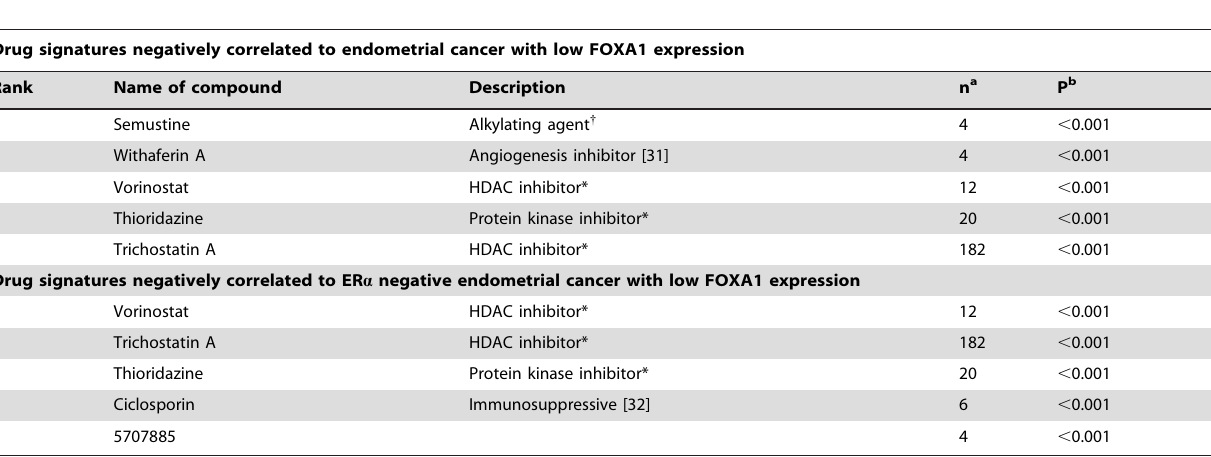
Table 2. Top ranked drugs and targets for therapy related to FOXA1 status, based on Connectivity Map